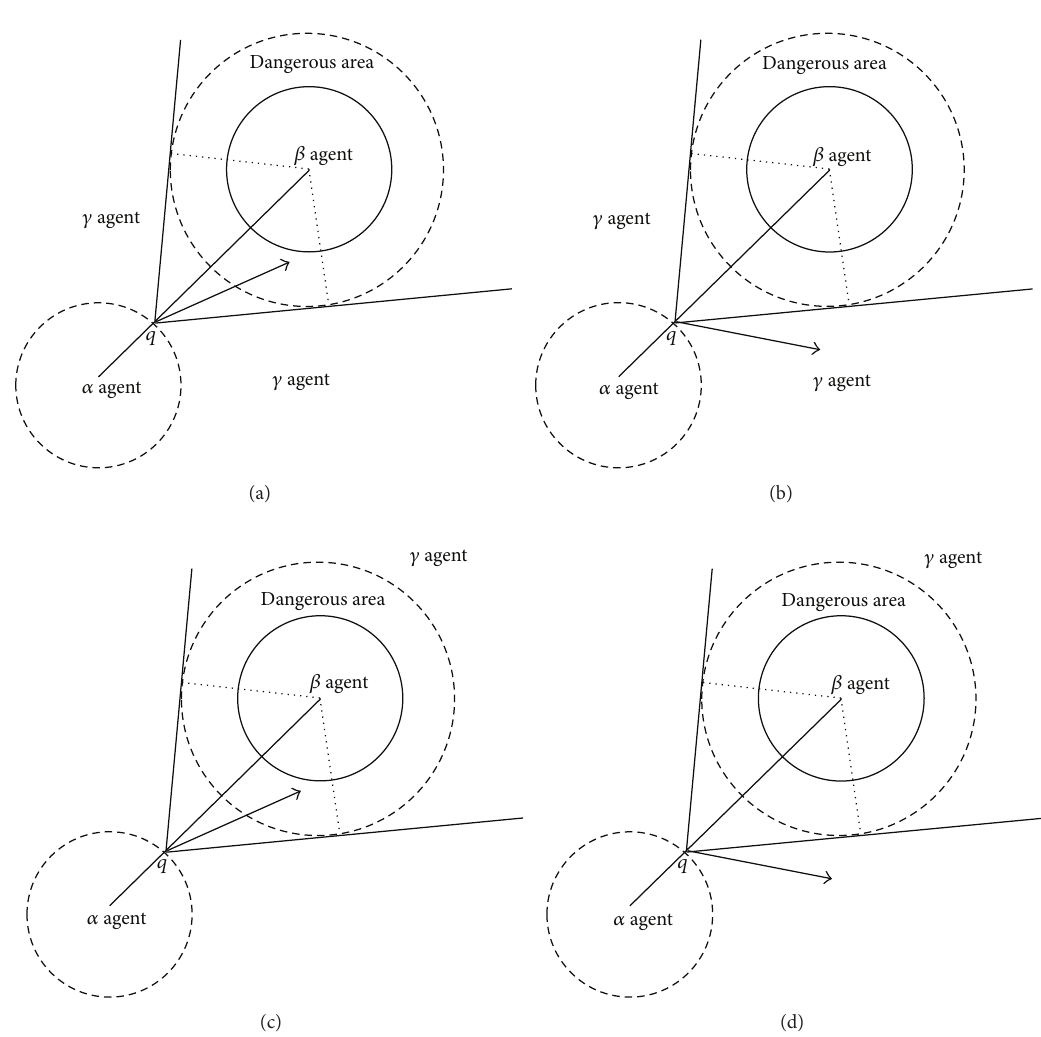
Figure 4: Different conditions between agents while flocking has not